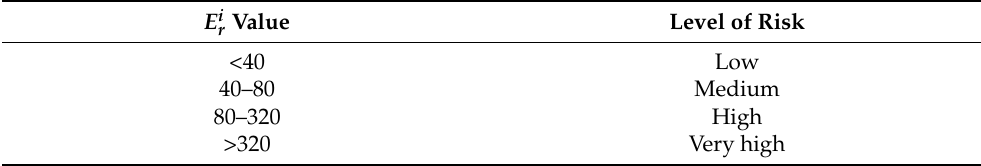
Table 6. ER indicator classification